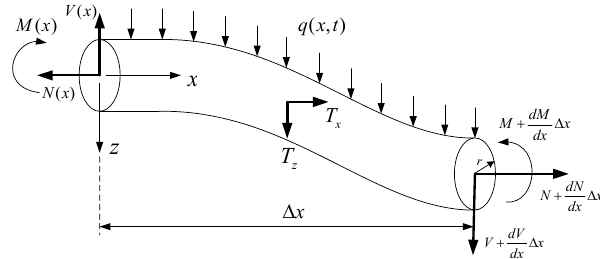
Figure 5. A beam element of circular